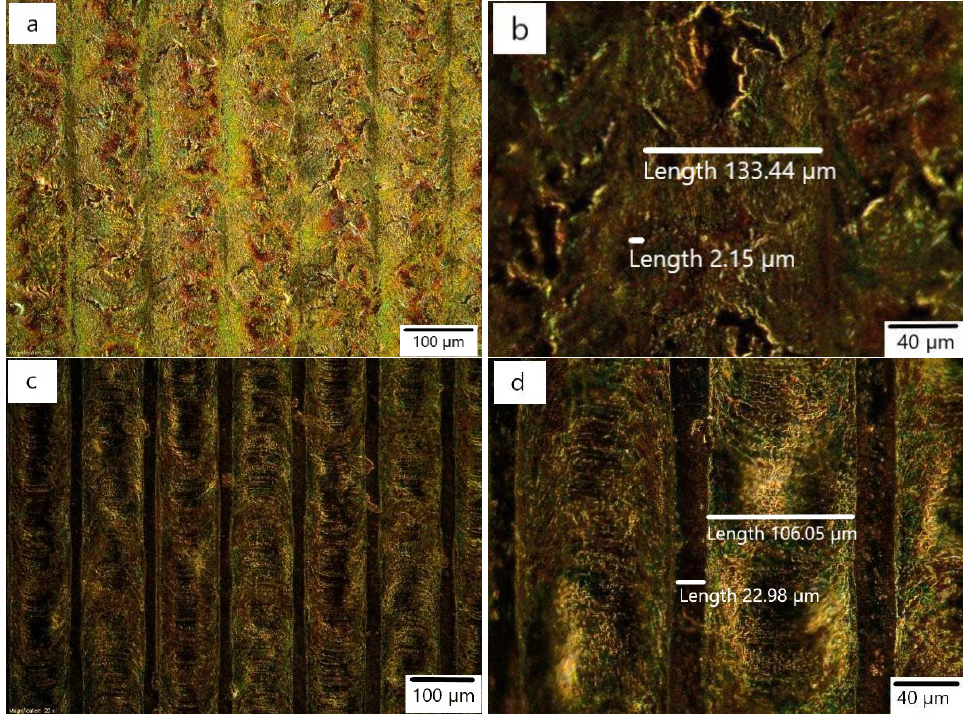
Figure 5. The 316L sample surface images after laser ejection. ( a ) Investment casting × 200.